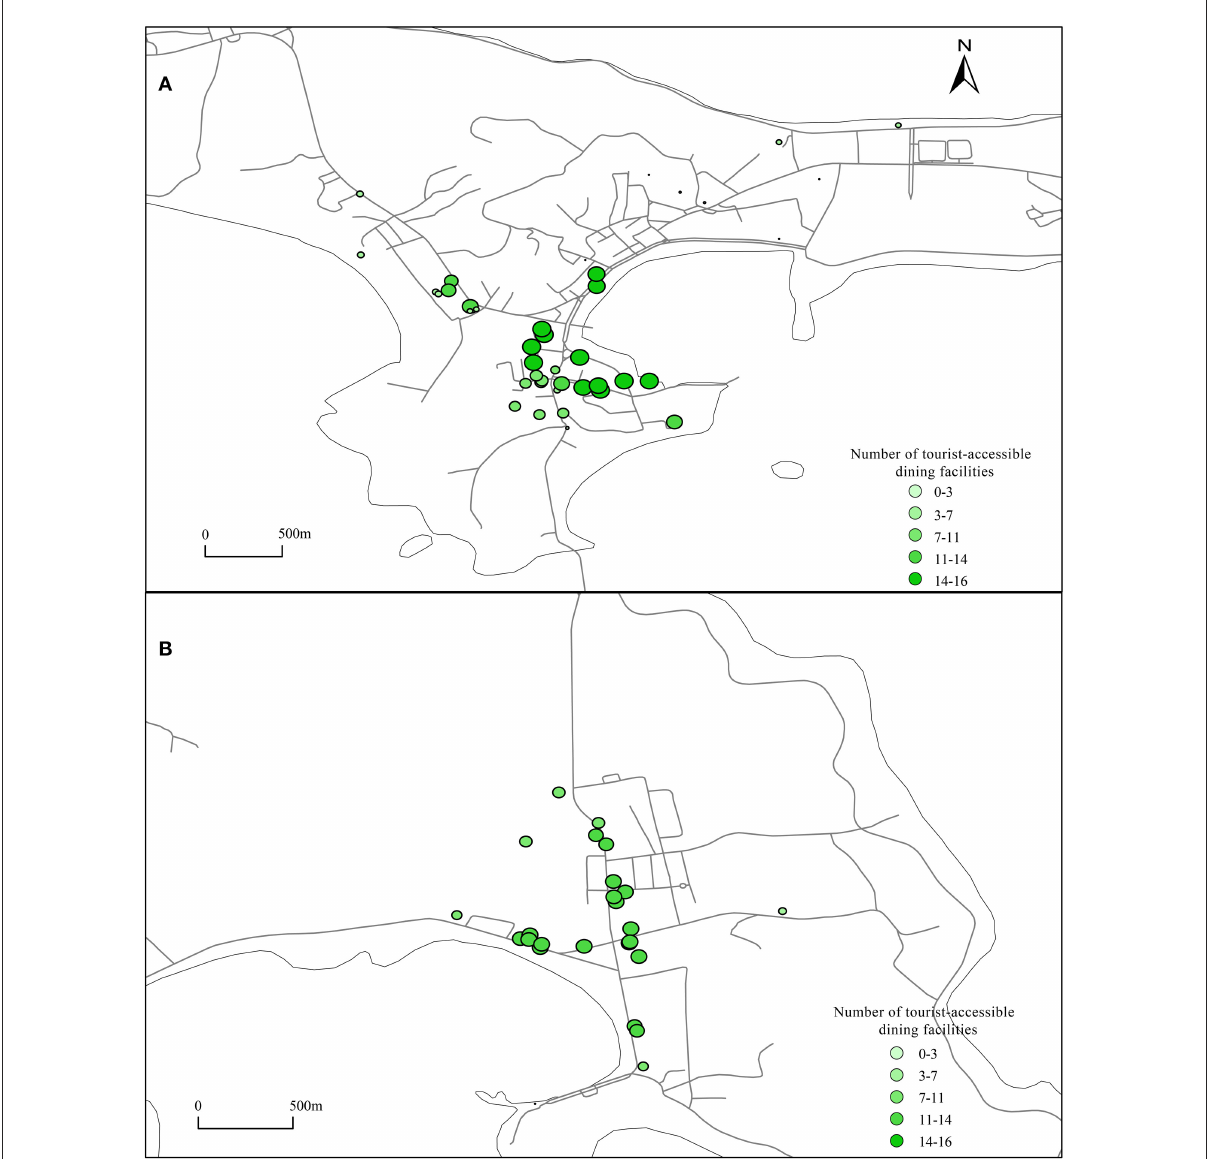
FIGURE6 Catering facilities accessible to tourists. (A, B) Using the UNA analysis tool, set the tourist accommodation facilities as the starting point, catering facilities as the ending point, import the road network, and calculate the number of catering facilities that can be reached from the tourist accommodations within a range of 800